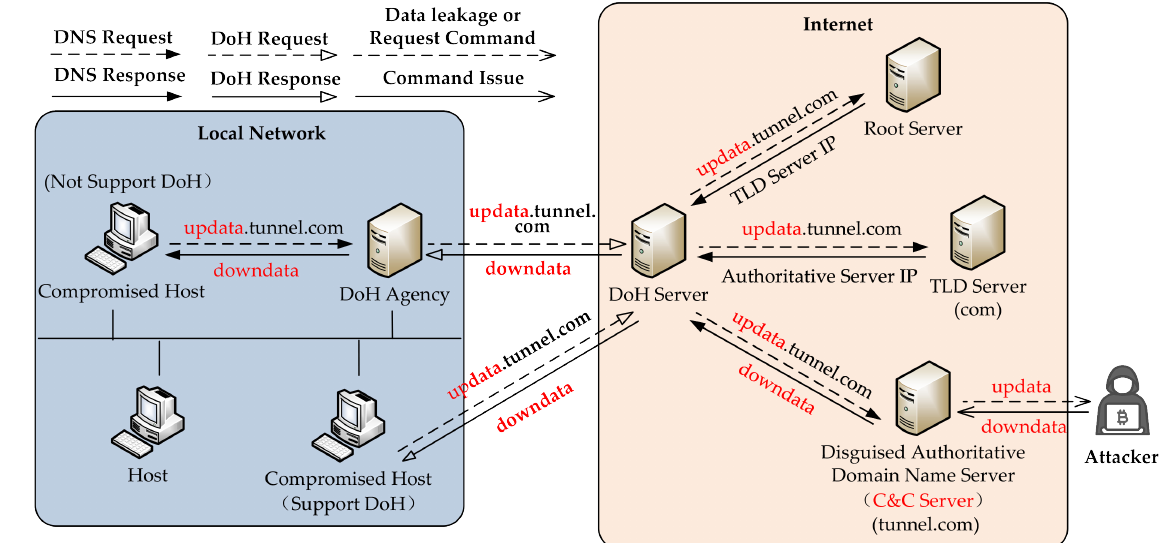
Figure 1. Data leakage and command control process based on DoH-encrypted DNS covert